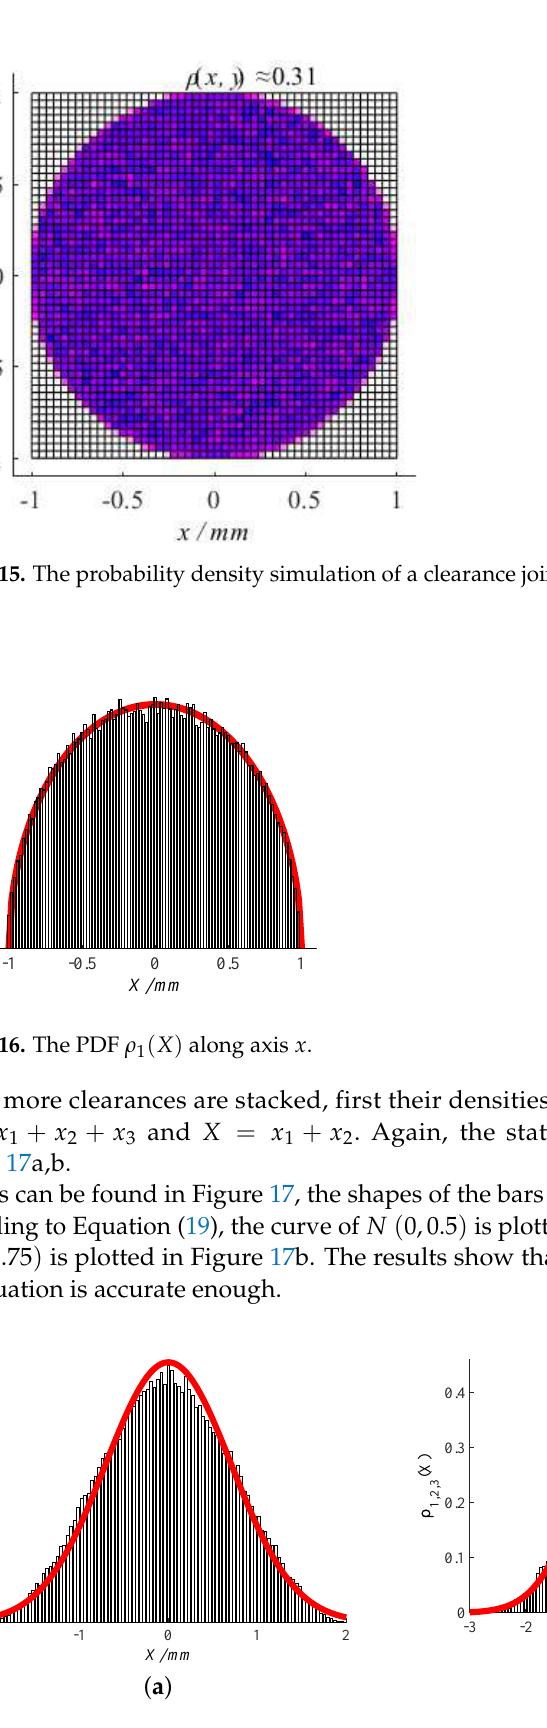
Figure 17. The PDFs along axis x . ( a ) ρ 1,2 ( X ) curve and bar chart. ( b ) ρ 1,2,3 ( X ) curve and bar